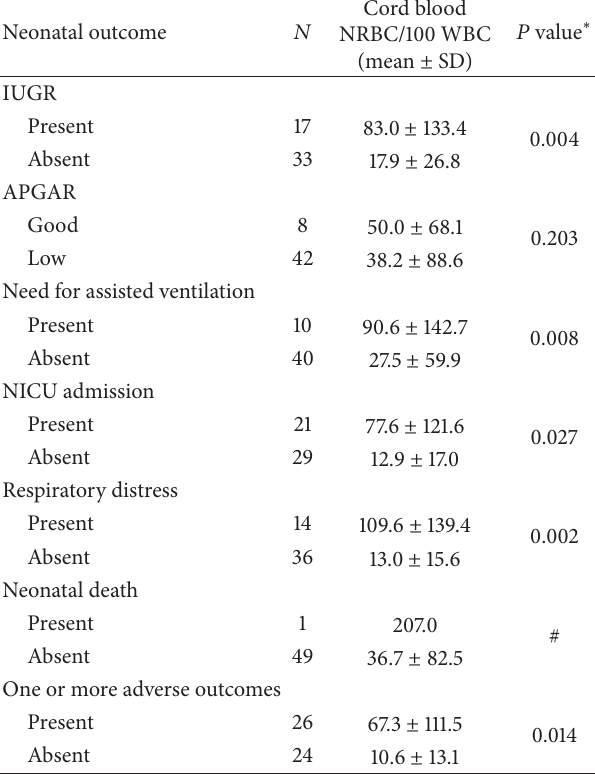
Table 3: Association of increased cord blood NRBC count with different neonatal outcomes studied within cases of preeclampsia group ( 𝑛 = 50